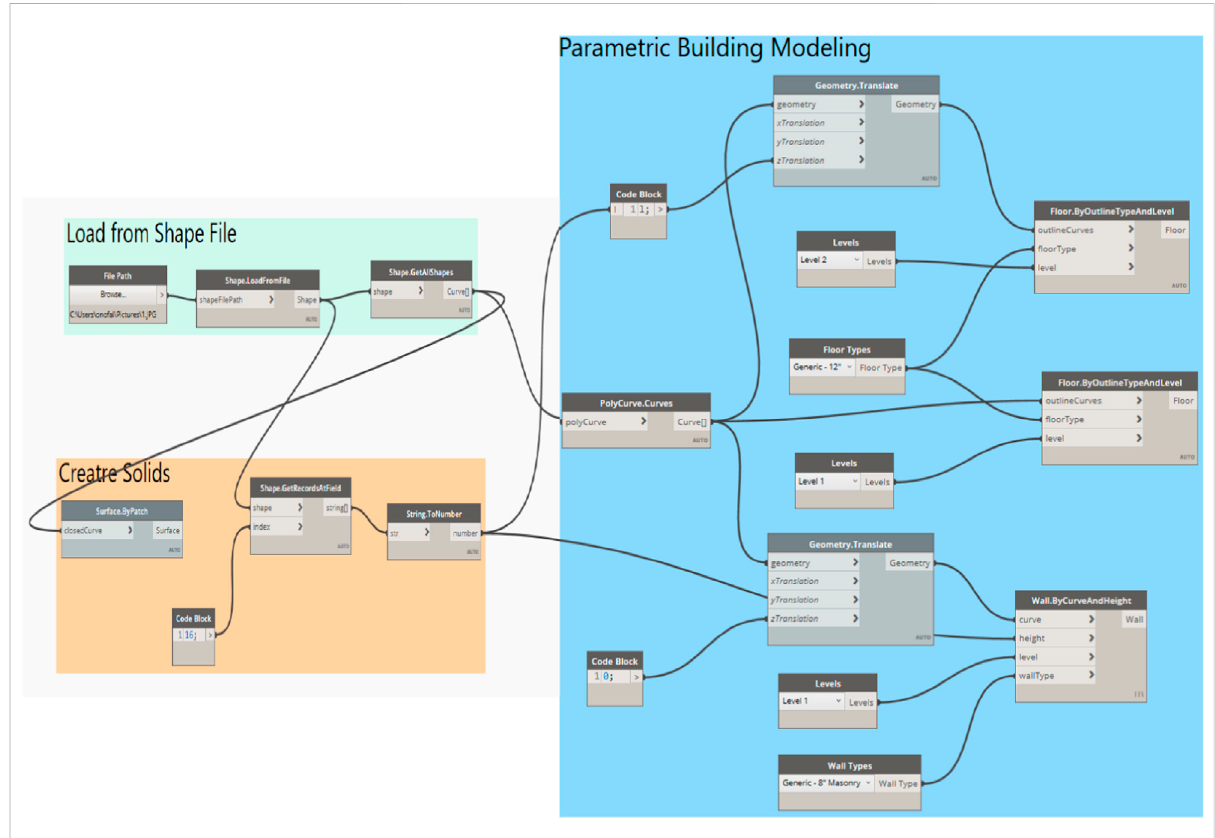
FIGURE 2 The logic behind the developed algorithm in terms of Revit Dynamo to link between the GIS shape fi le and parametric BIM model.